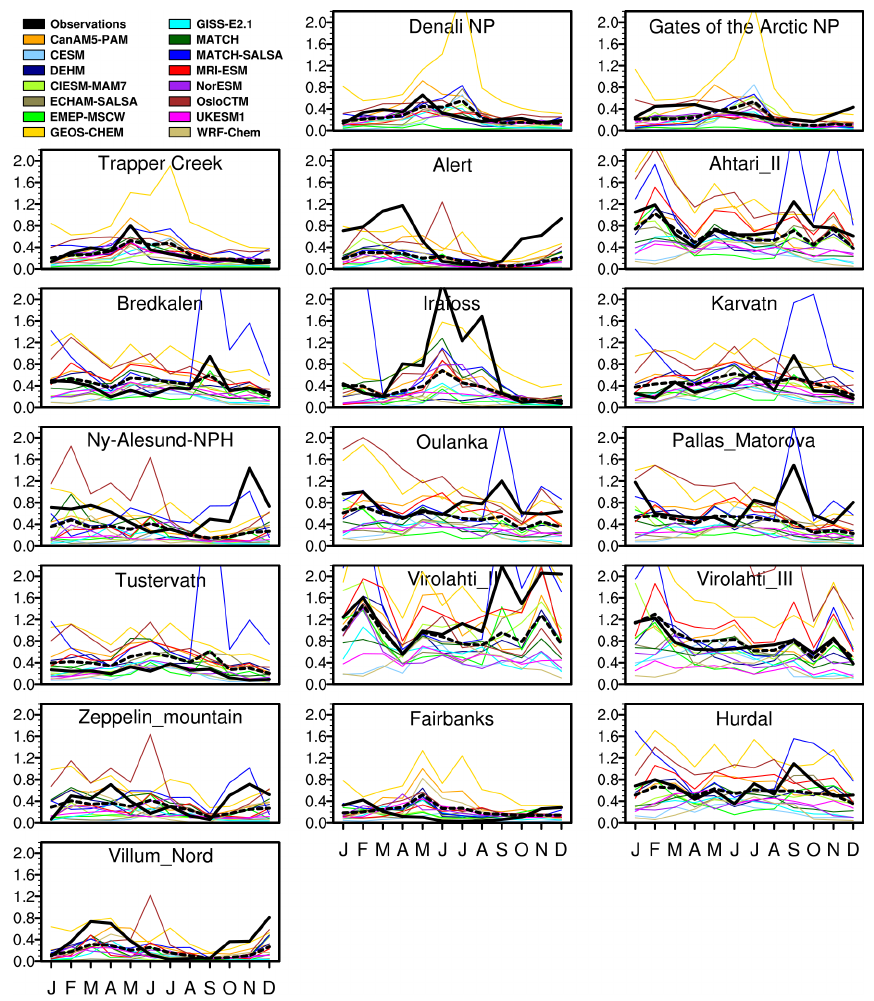
− concentrations (µg m − 3 ) at surface Arctic 4